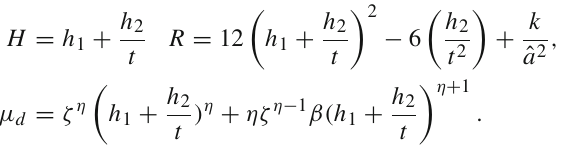
in the presence of radiation and DE dominated eras (left plot) while (cid:16) c is consistent for all chosen values of n (right